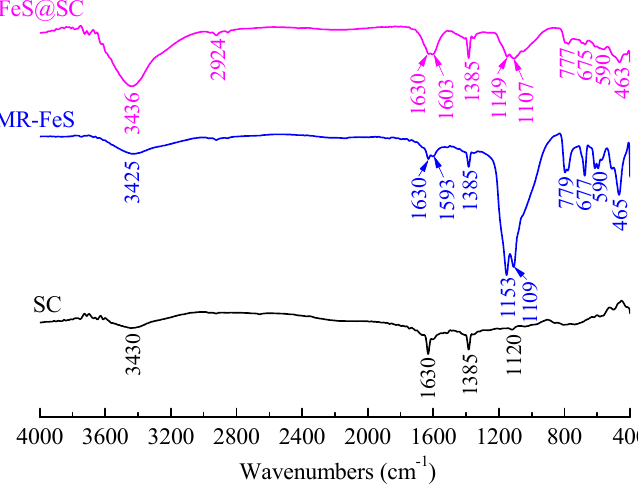
Figure 5. FTIR spectra of SC, MR – FeS, and MR – FeS@SC.